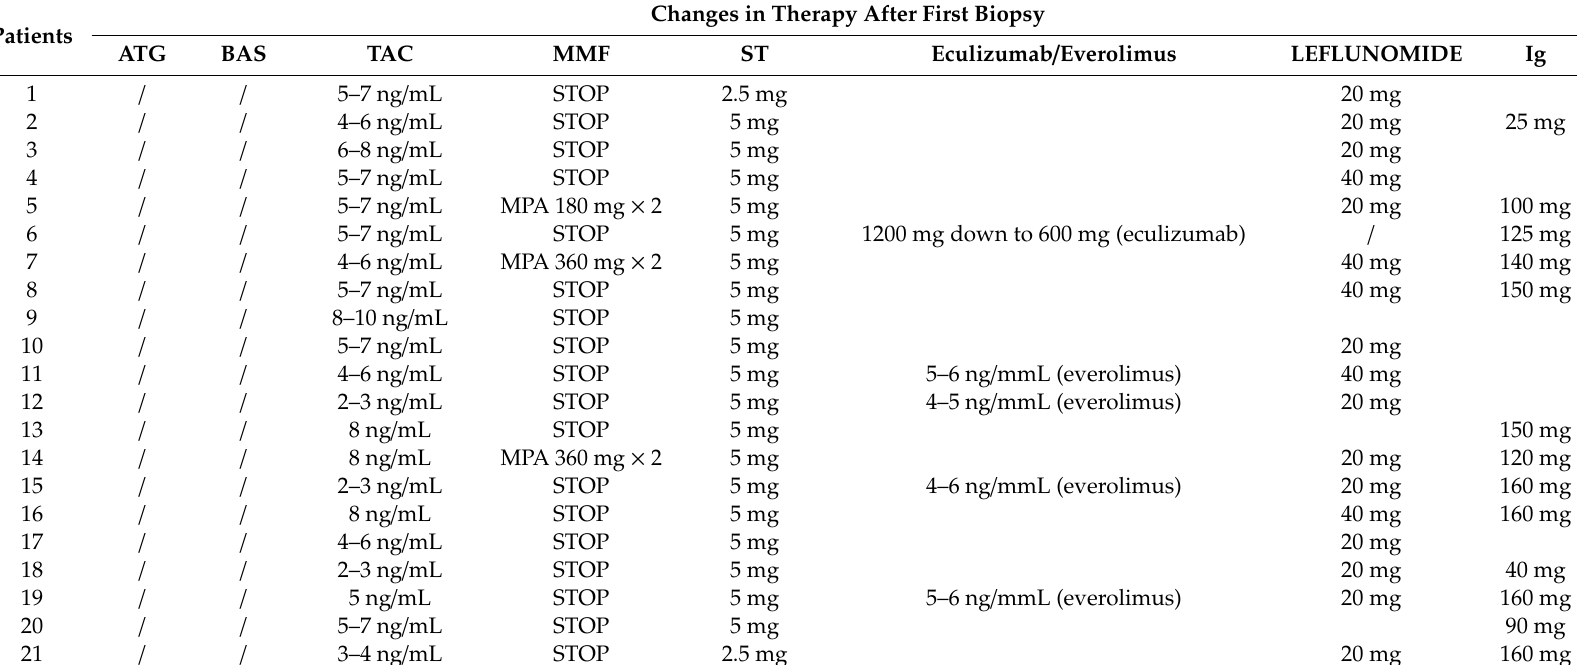
Table 4. Changes in therapy after first